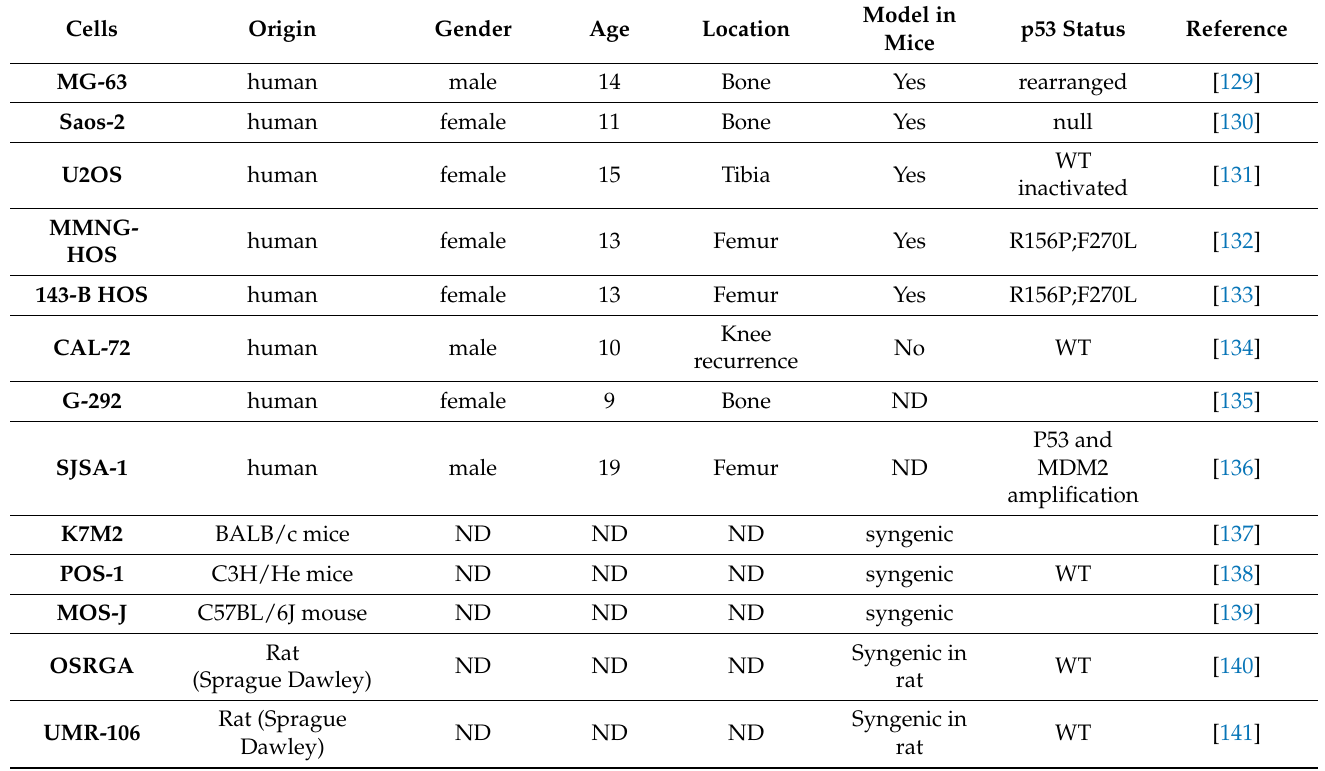
Table 3. Most of the used OS cell lines (ND: no